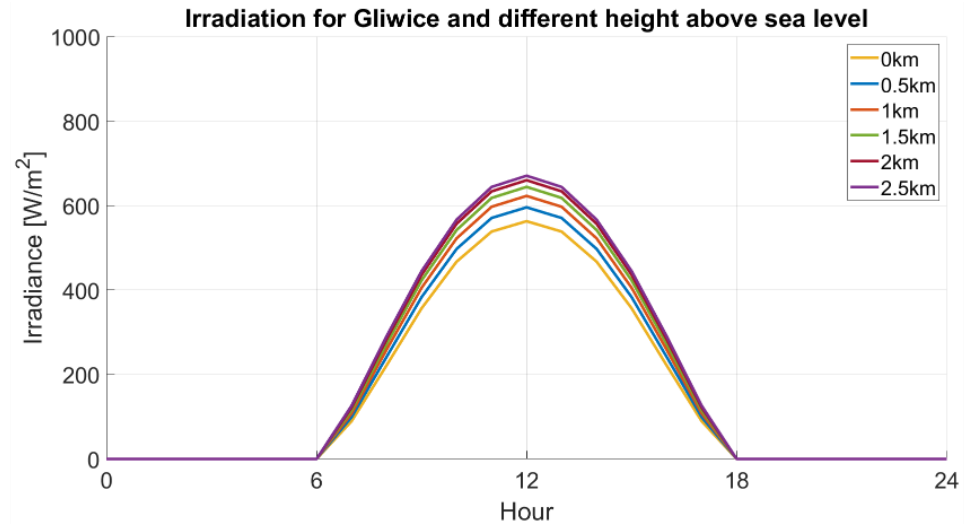
Figure 15. Irradiation for Gliwice in vernal equinox for different altitude.